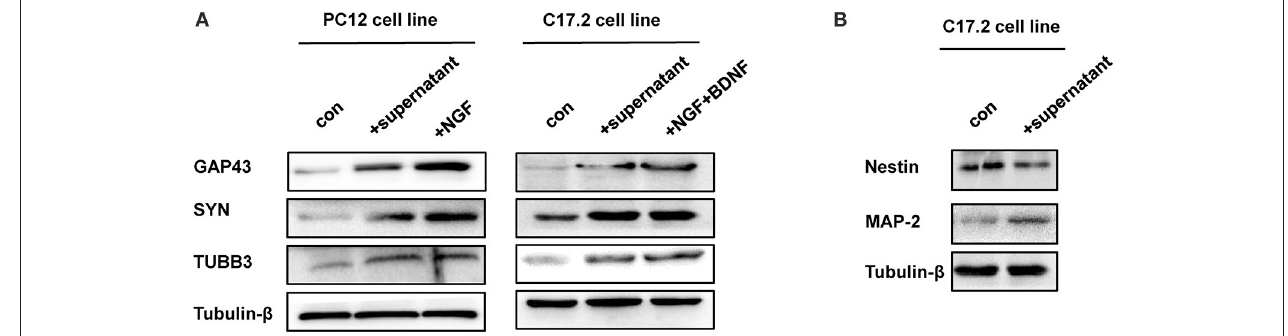
FIGURE 4 | Western blotting analysis of differentiation-related markers of PC12 cells and C17.2 cells treated with culture supernatant of M. smegmatis . (A) PC12 cells and C17.2 cells were treated with/without culture supernatant of M. smegmatis , differentiation related markers GAP43 (Growth Associated Protein 43), SYN (Synaptophysin) and TUBB3 (Tubulin beta-3 chain) were determined by western blot analysis; (B) Neuron related markers Nestin and MAP-2 were determined by western blot analysis in C17.2 cells.